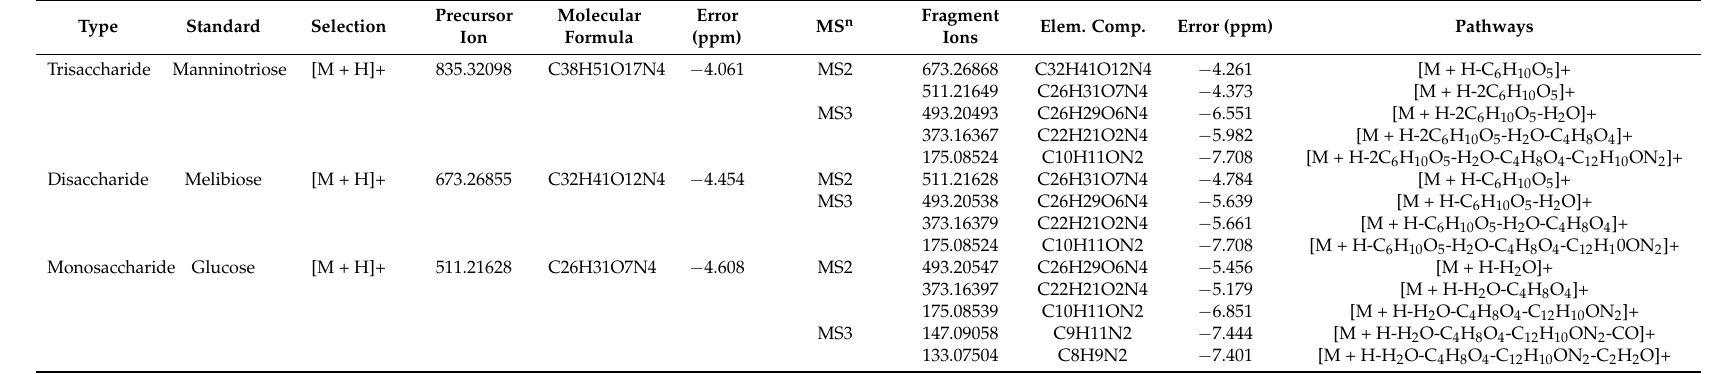
Table 2. MS n data and proposed fragmentation pathways of the three reference